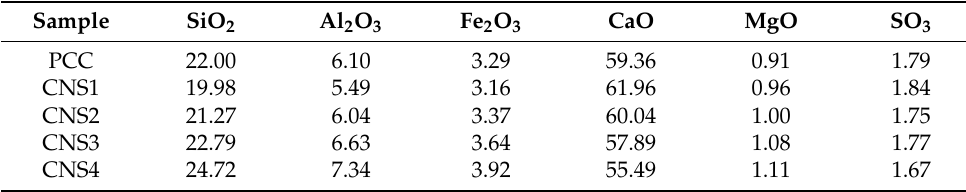
Table 2. Chemical composition (% w/w ) of cement with variation of Napa soil.